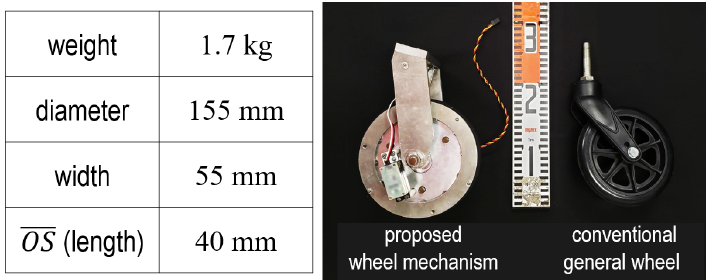
Figure 10. Step-ascending prototype and its specification.